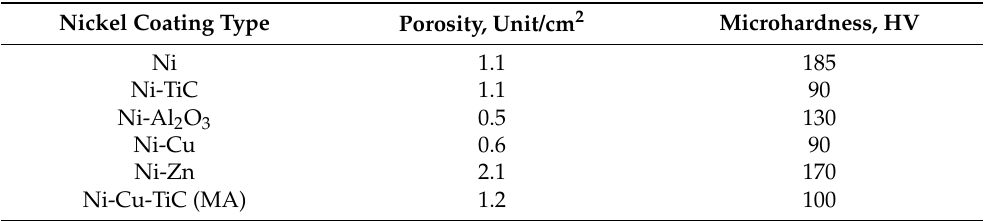
Table 2. The average values of porosity and microhardness of the studied types of coatings. Nickel Coating